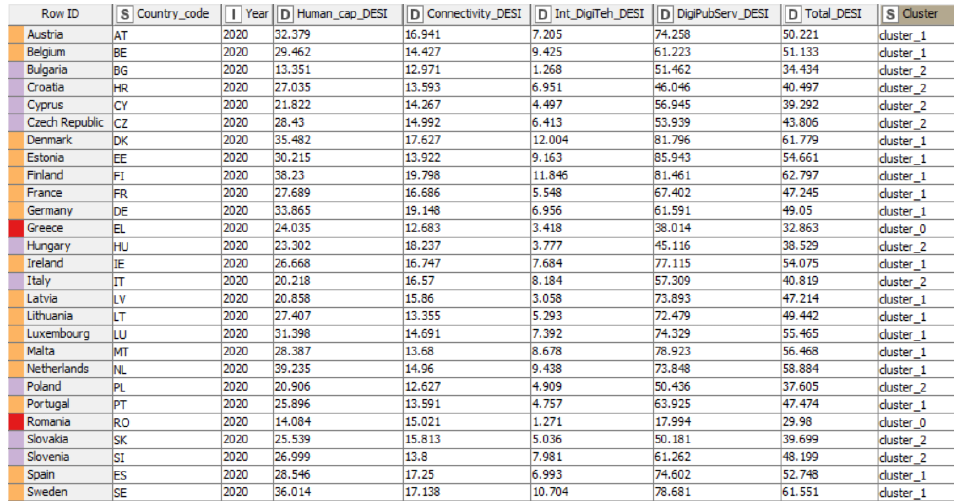
Figure 11. Distribution of countries based on digitalization indicators. Source: authors’ compilation in KNIME analytics platform.